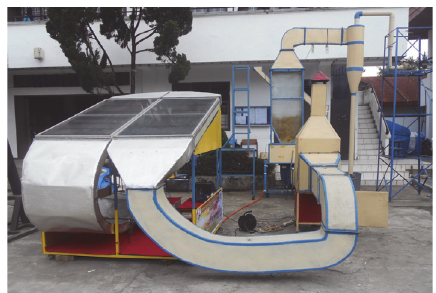
Figure 1: Photograph of the solar assisted heat pump fluidized bed dryer integrated biomass furnace.